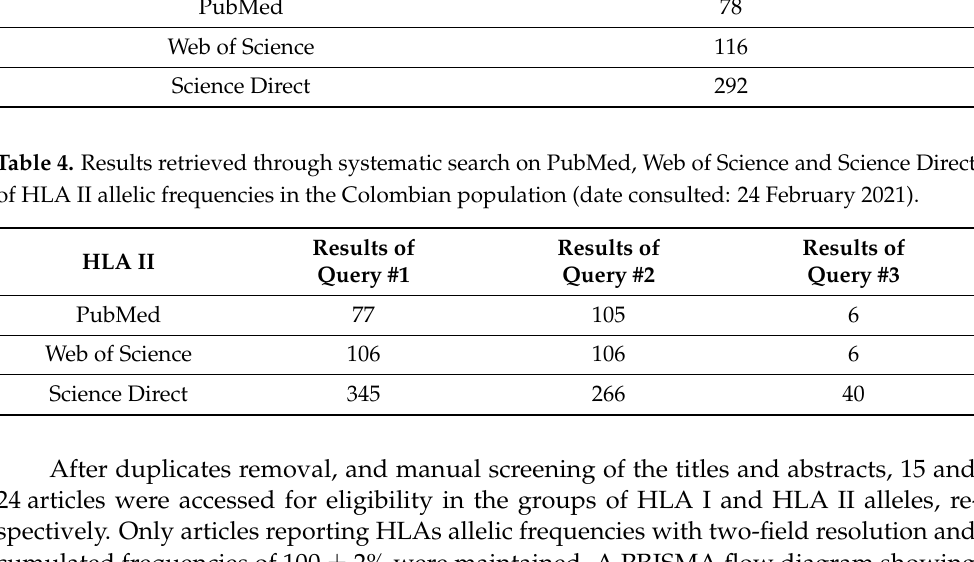
Table 3. Results retrieved through systematic search on PubMed, Web of Science and Science Direct of HLA I allelic frequencies in the Colombian population (date consulted: 24 February 2021). HLA I